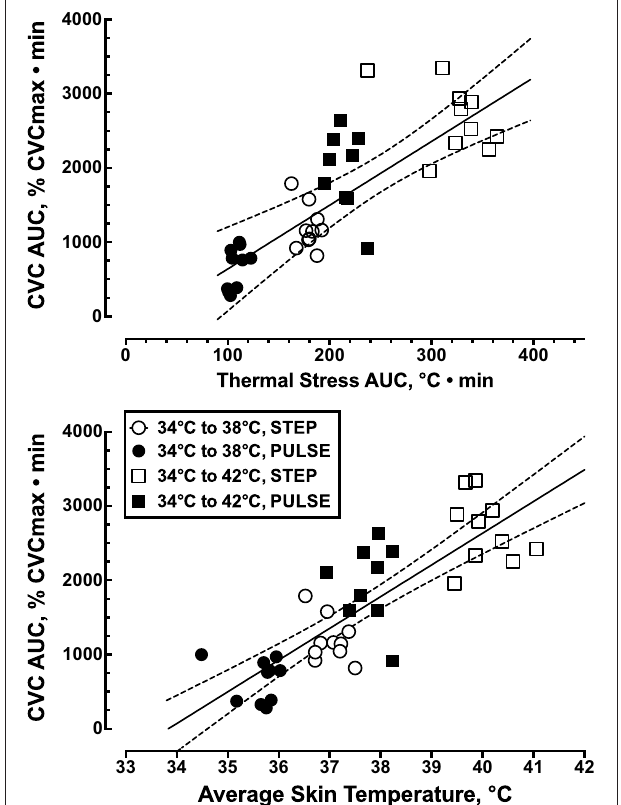
FIGURE 4 | Relationship between the overall thermal stress applied locally to the skin, expressed as the average skin temperature ( r 2 = 0.69, p < 0.0001, n = 39), and the overall skin blood flow response, expressed as the area under the skin blood flow-time curve ( r 2 = 0.62, p < 0.0001, n = 39).